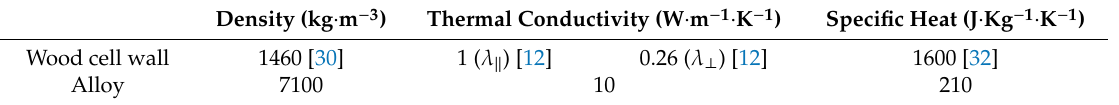
Table 1. Thermal parameters of wood cell walls and the metal alloy.